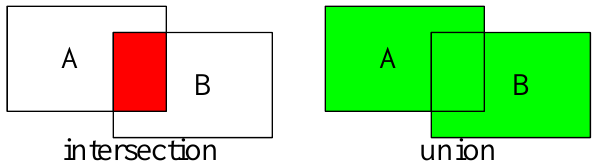
Figure 3. Intersection and Union of two overlapping boxes A and B.